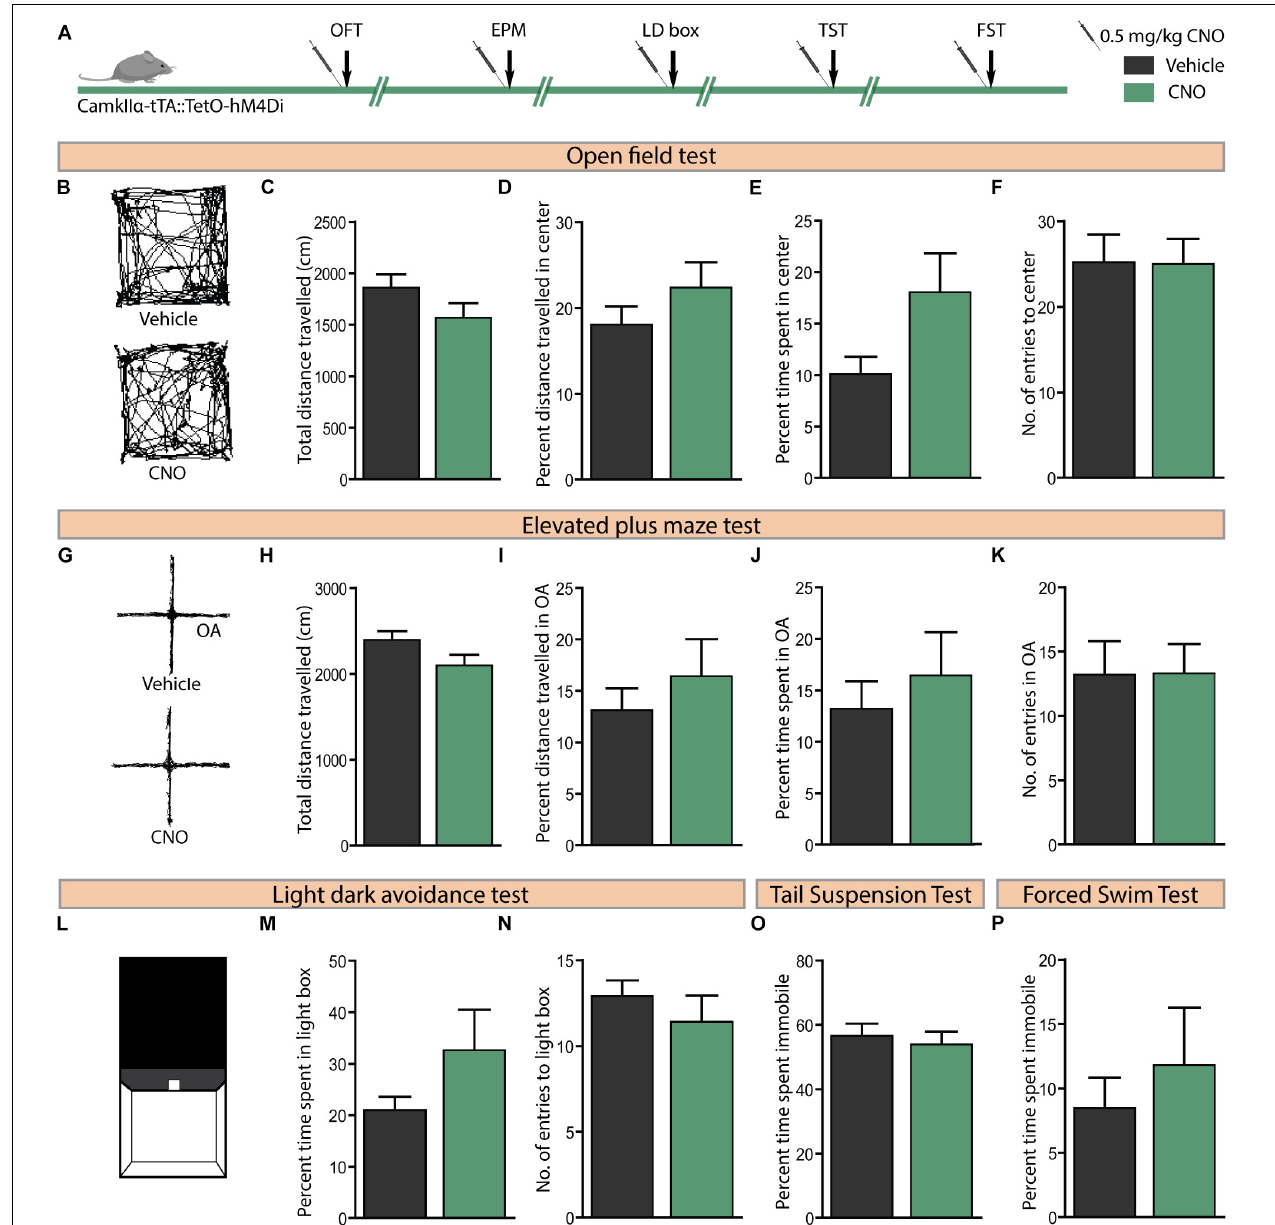
FIGURE 5 | Acute CNO-mediated DREADD inhibition of CamKII α -positive forebrain excitatory neurons does not alter anxiety or despair-like behaviour. (A) Shown is a schematic of the experimental paradigm used to determine the influence of acute CNO (0.5 mg/kg)-mediated hM4Di DREADD inhibition of CamKII α -positive forebrain excitatory neurons in adult male bigenic CamKII α -tTA:TetO-hM4Di mice on anxiety and despair-like behaviour. Treatment groups were subjected to a battery of anxiety and despair-like behavioural tasks, with an interim washout period of 7–10 days ( n = 9–10/group). (B) Shown are representative tracks from a vehicle and CNO-treated CamKII α -tTA:TetO-hM4Di mouse in the OFT (B–F) . CNO-mediated hM4Di DREADD inhibition of CamKII α -positive forebrain excitatory neurons did not influence anxiety-like behaviour in the OFT as indicated by no change observed in the total distance travelled (C) , percent distance travelled in the centre (D) , percent time spent in the centre (E) , and number of entries made to the centre (F) as compared to vehicle-treated controls. (G) Shown are representative tracks from a vehicle and CNO treated CamKII α -tTA:TetO-hM4Di mouse in the EPM test (G–K) . CNO-mediated hM4Di DREADD inhibition of CamKII α -positive forebrain excitatory neurons did not influence the total distance travelled (H) , percent distance travelled in the open arms (OA) (I) , percent time spent in the open arms (J) , and number of entries to the open arms (K) of the EPM. (L) Shown is an illustration of the chamber used in the light–dark (LD) avoidance test (L–N) . CNO-mediated hM4Di DREADD inhibition of CamKII α -positive forebrain excitatory neurons did not influence percent time spent in the light chamber (M) and number of entries made to the light chamber (N) . CNO-mediated hM4Di DREADD inhibition of CamKII α -positive forebrain excitatory neurons did not influence despair-like behaviour in the TST and FST, with no change noted in percent immobility time in both the TST (O) and the FST (P) , as compared to vehicle-treated CamKII α -tTA:TetO-hM4Di mice. Results are expressed as the mean ± SEM ( n = 9–10/group), two-tailed, unpaired Student’s t -test.